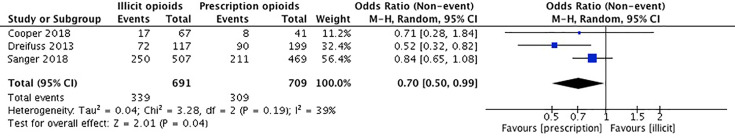
Forest Plot for Illicit Opioid Use.